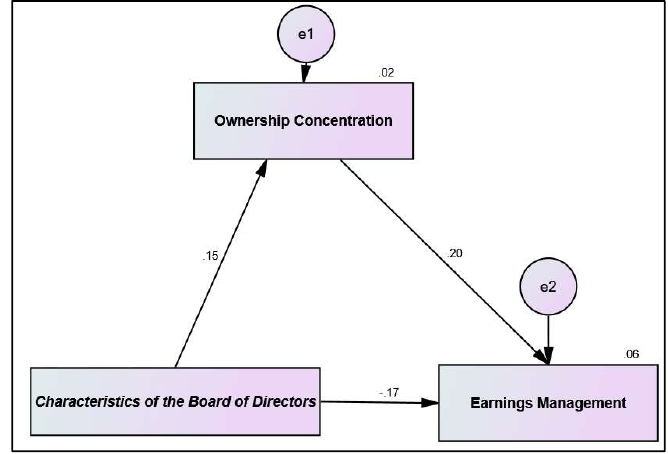
Fig. 2. Impact Coefficients of Family Ownership Concentration on the relationship between Board of Directors Characteris- tics combined and earnings